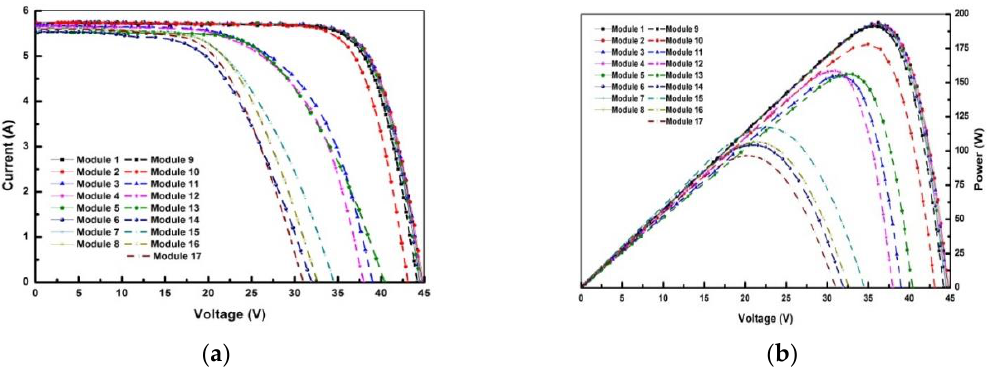
Figure 7. The current-voltage characteristics ( a ) and power-voltage characteristics ( b ) of 17 solar modules dismounted from PID-affected module string 7. Although solar module 14 undergone a lower negative potential than that of module 15 and module 16 in the field, module 14 shows a more power degradation than module 15 and module 16.